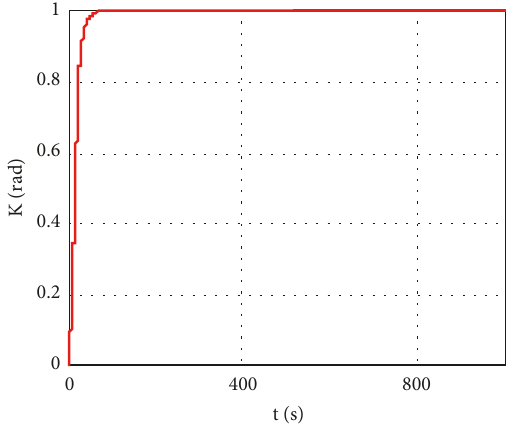
Figure 9: Time dependence of the vessel heading angle during slowed rotation at a given heading angle of 57.3 degrees for values 𝑧 ∗ = 0.005𝑟𝑎𝑑 ⋅ 𝑠 −1 , 𝑧 ∗ = 1𝑟𝑎𝑑 . 3 6 and 𝑧 ∗ 3 = 0.05 𝑟𝑎𝑑 ⋅ 𝑠 −1 , corresponding to a slowed and accelerated vessel rotation at a given heading angle of 57.3